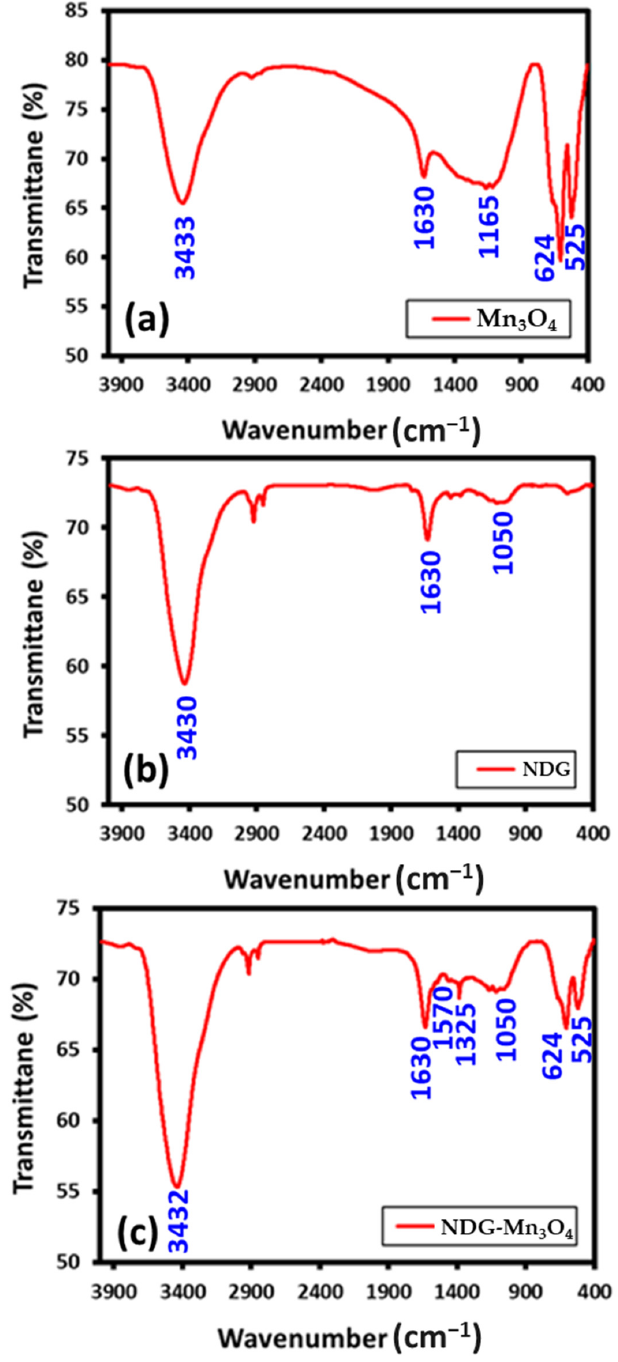
Figure 3. FT-IR spectra of ( a ) Mn 3 O 4 NPs, ( b ) NDG and ( c ) NDG-Mn 3 O 4 nanocomposite.